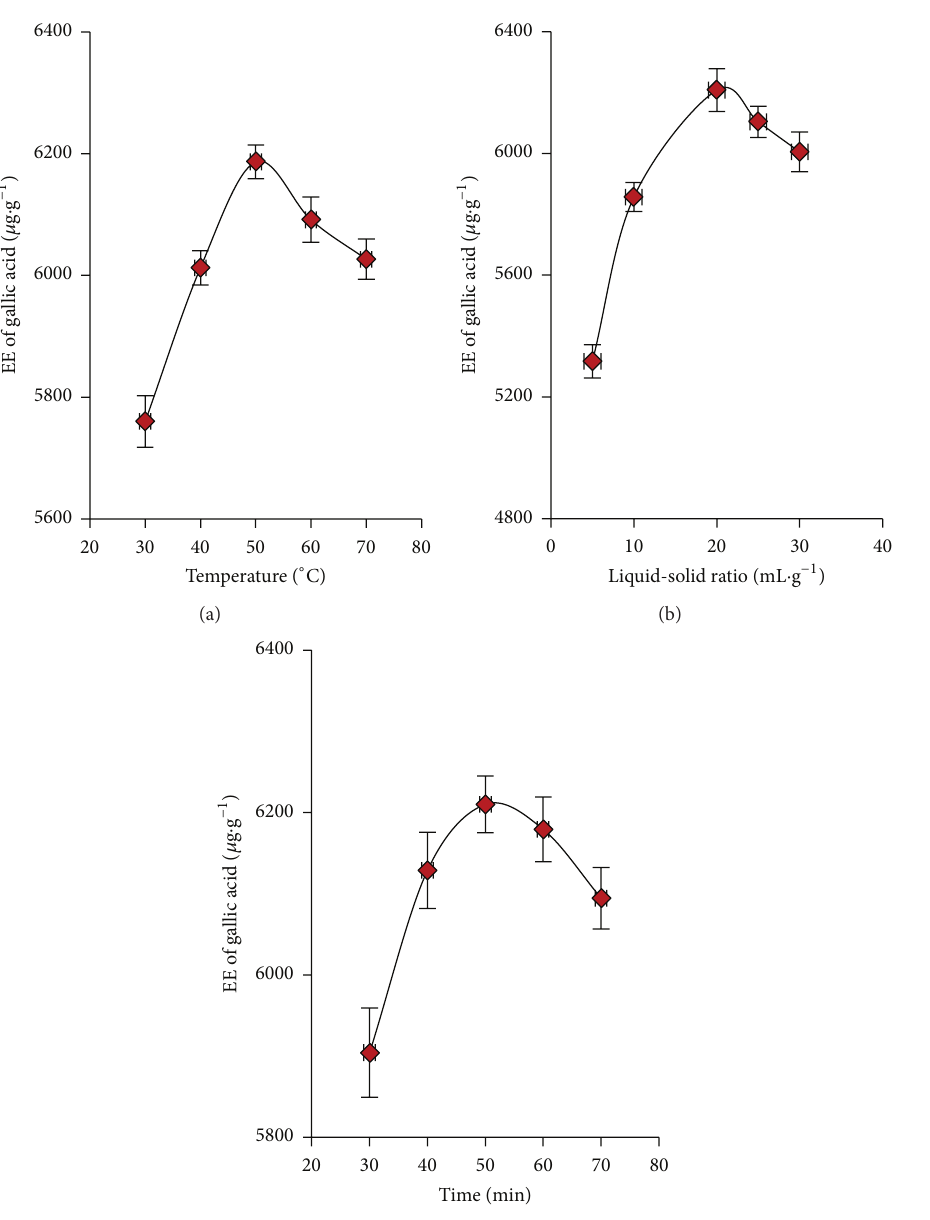
Figure 1: Effect of temperature (a), liquid-solid ratio (b), and time (c) on the extraction efficiency of gallic acid with 70% ethanol as solvent. Extraction efficiency is expressed as measured values of sample